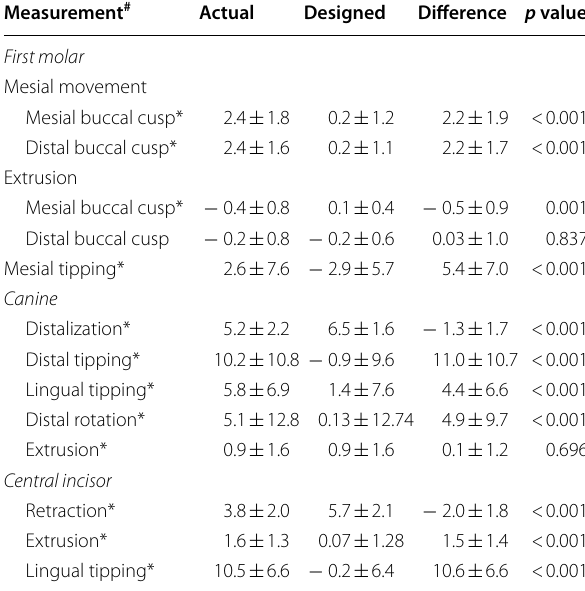
Table 3 Comparison of actual and designed tooth